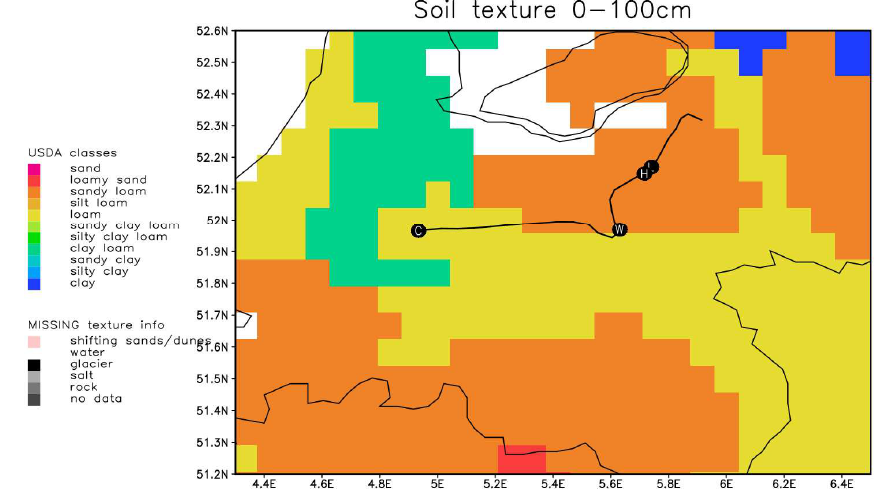
Fig. 4. Soil classification (depth 0–100cm) for the smallest grid in the domain. Along the flight track (given as a black line) the location of the observational sites are also given: C – Cabauw; W – Wageningen; H – Harskamp; L – Loobos.